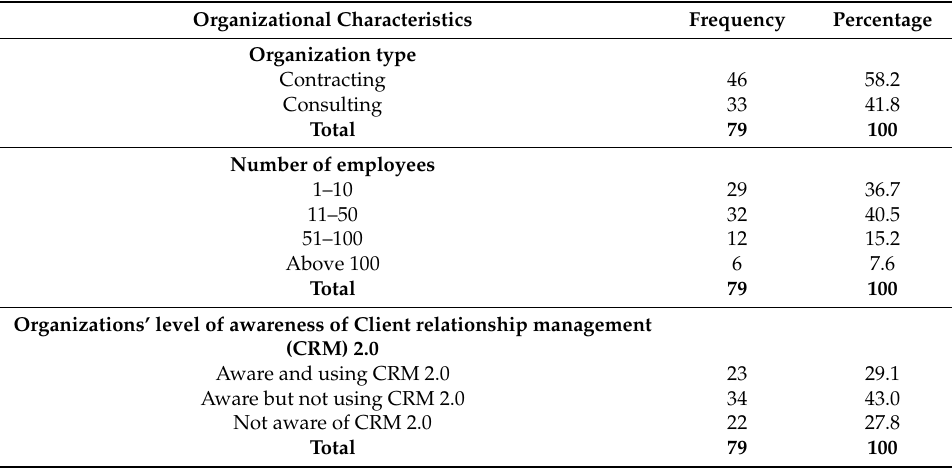
Table 2. Percentage distribution of organizational